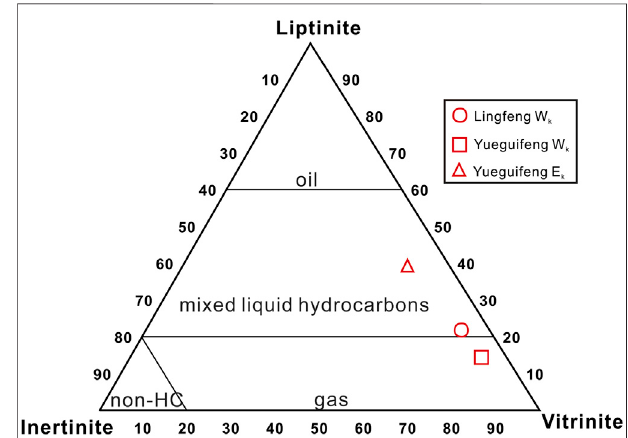
FIGURE 7 | Ternary plots of the maceral composition, showing anticipated hydrocarbon phase of the selected samples in the Lishui Sag (modi fi ed after Tissot and Welte,